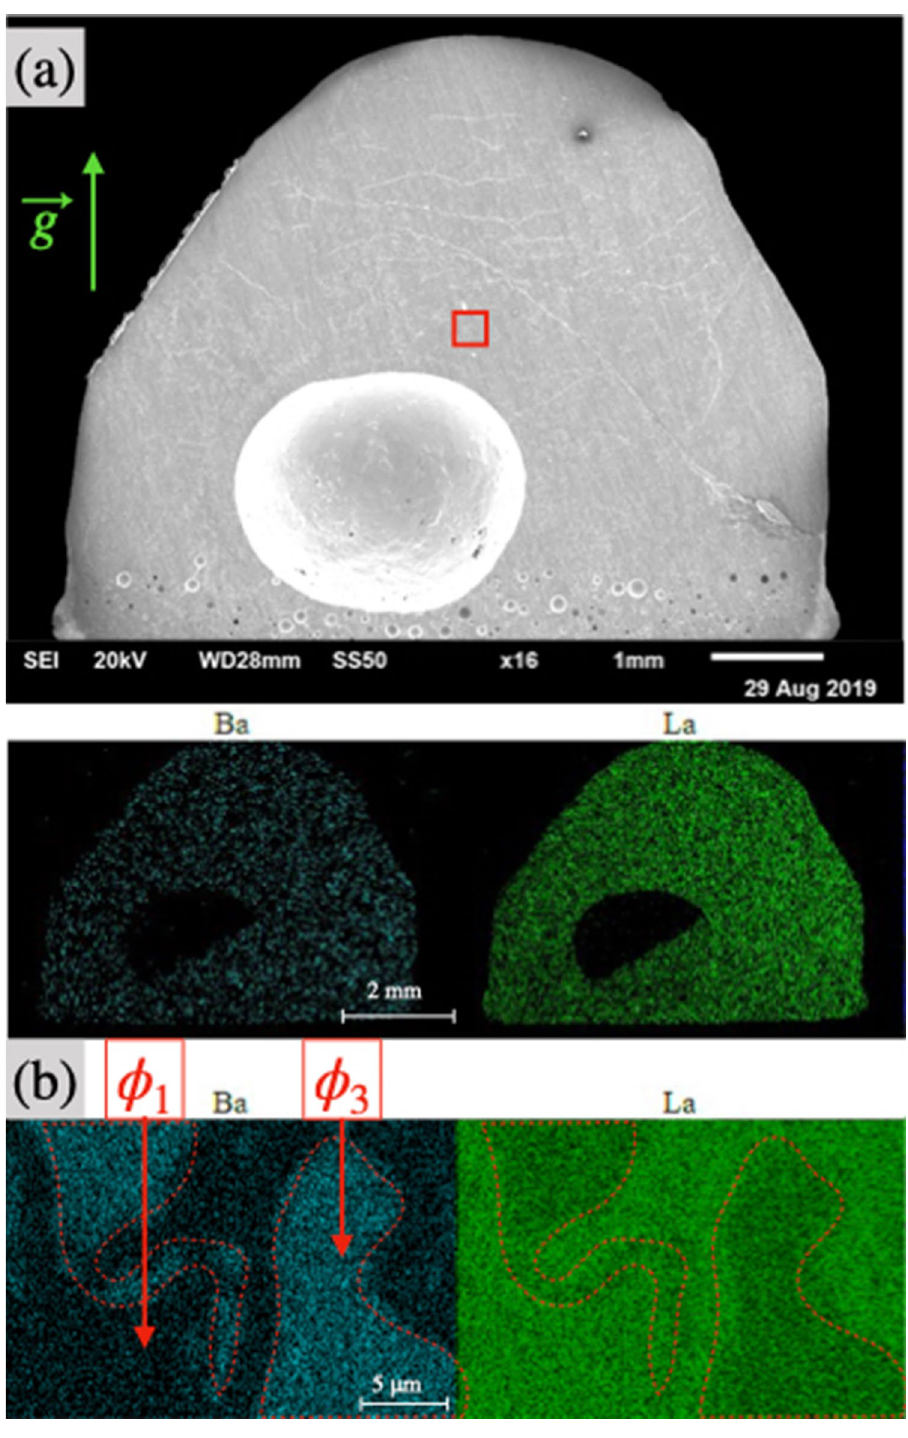
Figure 5. ( a ) SEM equipped with a single EDS detector images of (BaS) 0.25 - ( La 2 S 3 ) 0.75 sample acknowledging a single macrophase; ( b ) zoom on the red rectangle to observe the φ 1 and φ 3 phase separation on a microscale for (BaS) 0.25 - ( La 2 S 3 ) 0.75